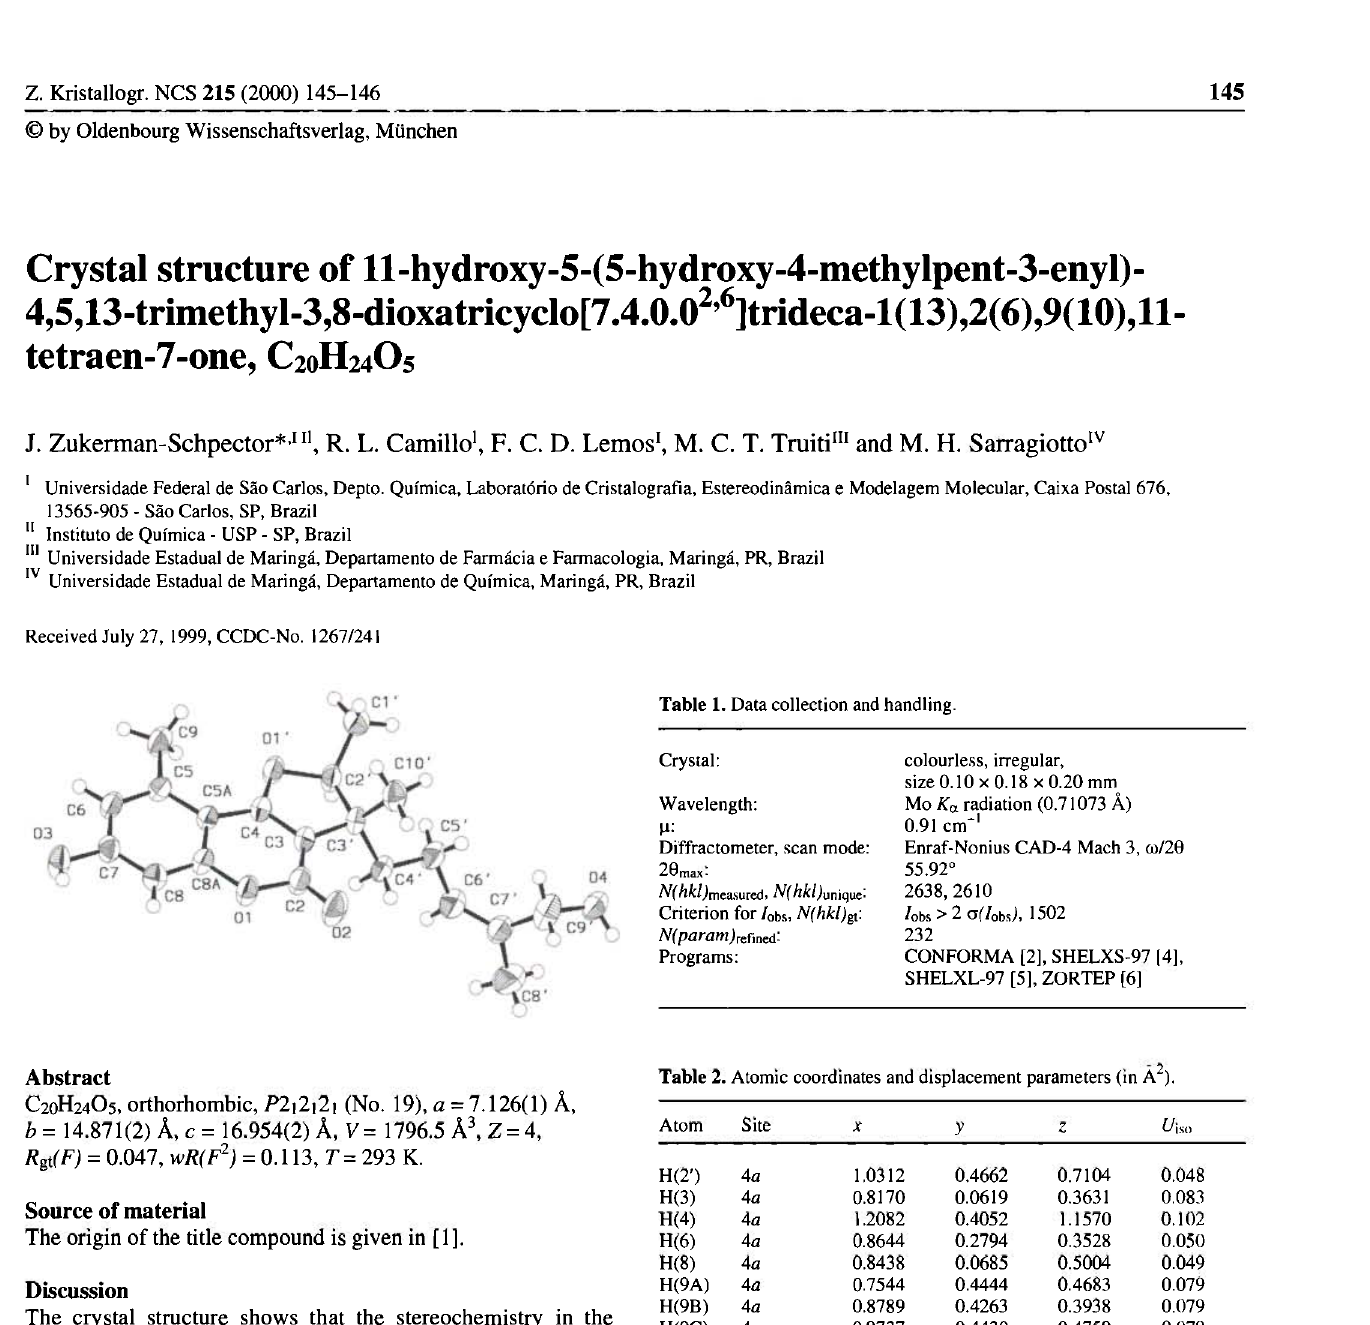
Table 2. Atomic coordinates and displacement parameters (in A 2